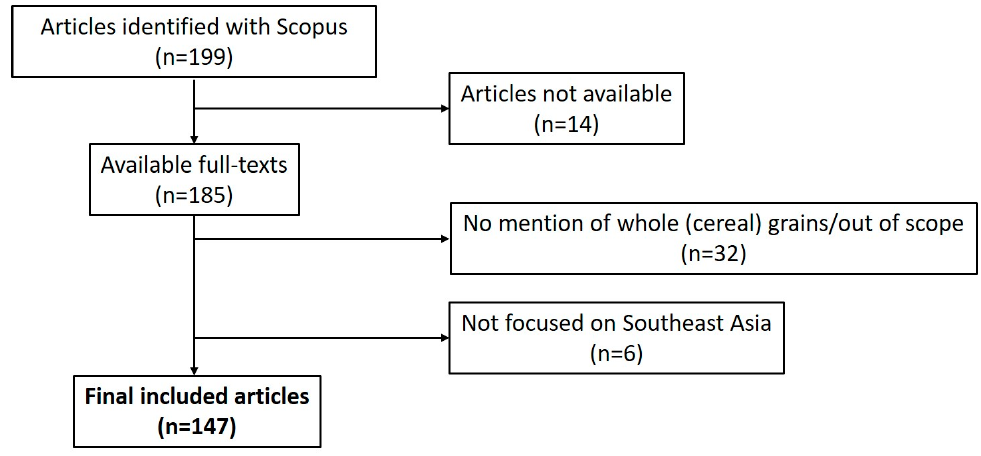
Figure 1. Overview of the literature search approach.